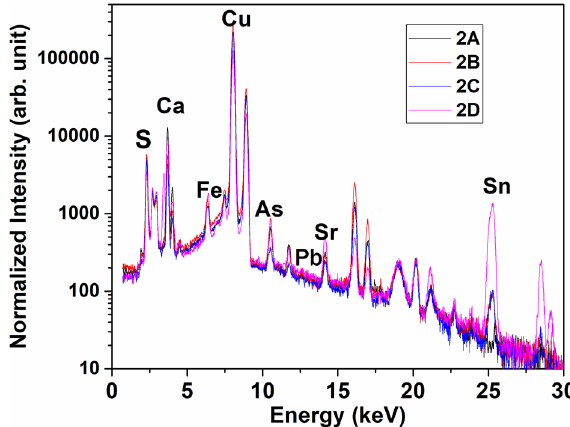
Figure 6. XRF spectra of the powder samples of helmet 2.